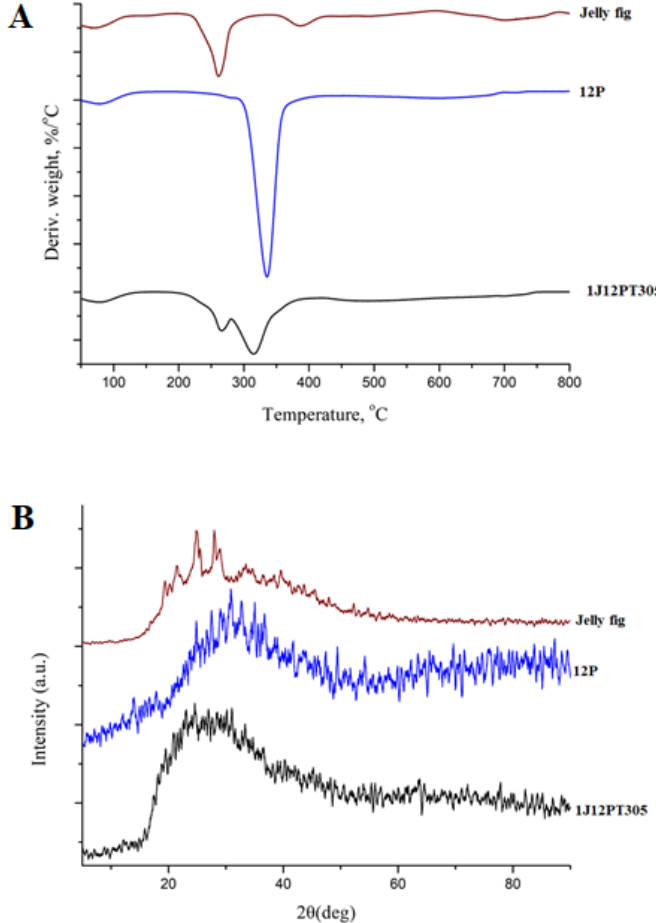
Figure 6. ( A ) Thermogravimetric curves of JFP powder, pullulan and JFP/pullulan nanofibers; ( B ) XRD patterns of JFP, pullulan and JFP/pullulan nanofibers.